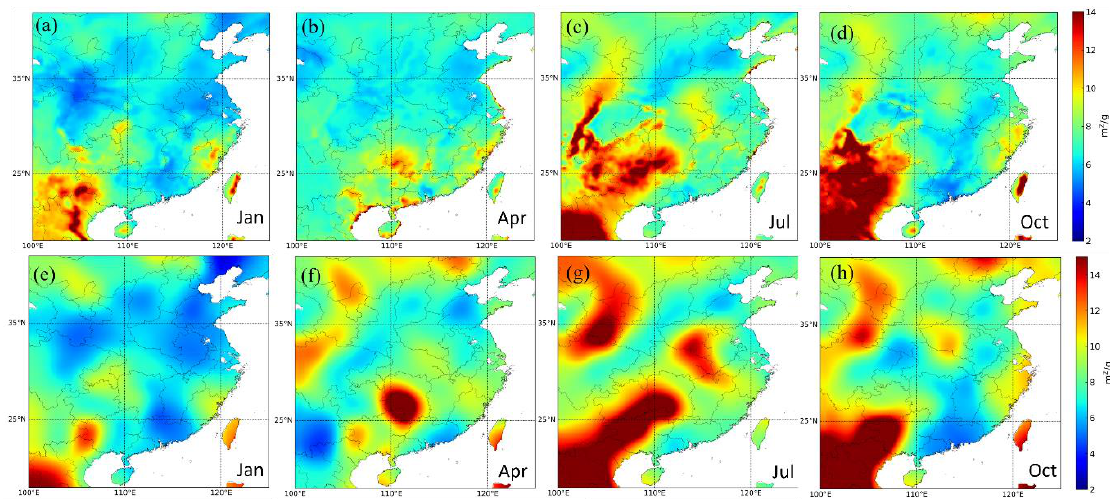
Figure 4. Monthly spatial distribution of aerosol characteristics (K): ( a – d ) are fitted by WRF-Chem model parameters; ( e – h ) are fitted by station meteorological parameters.